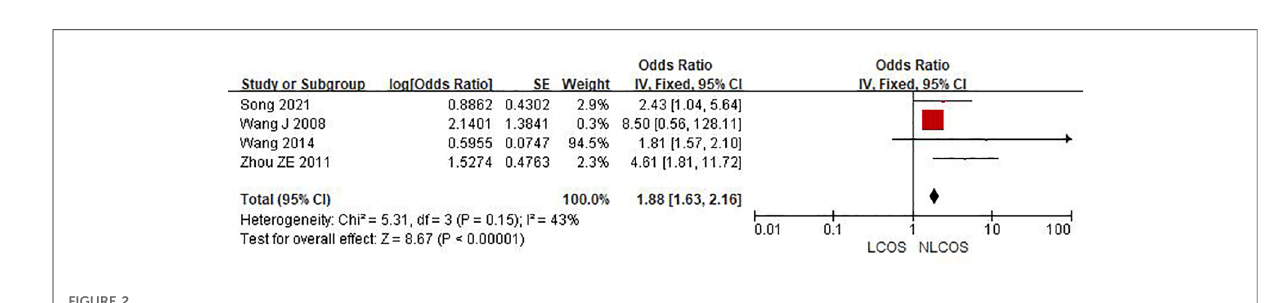
FIGURE 2 Age of children in forest